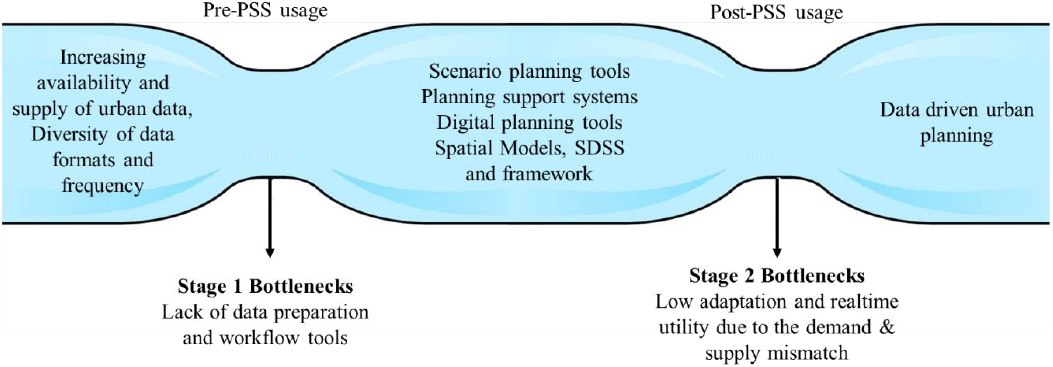
Figure 1. Key stages of bottlenecks from data to data-driven planning.